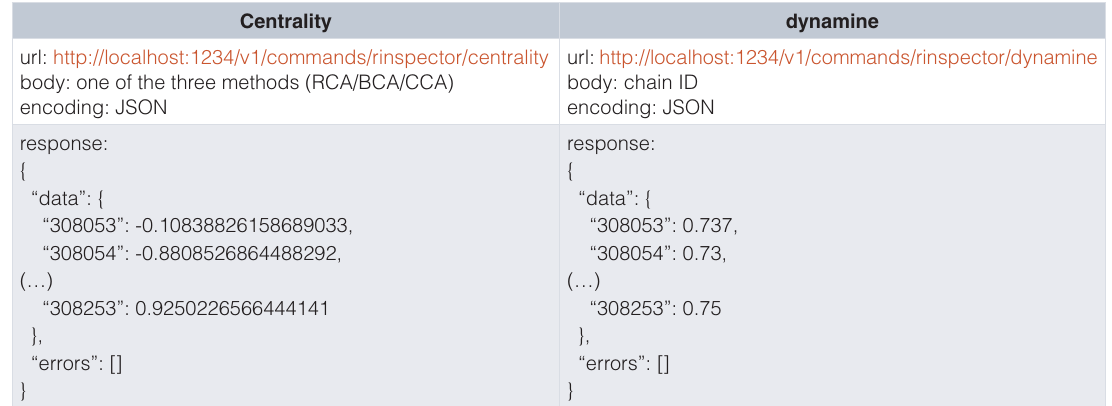
Table 1. Parameters and responses for centrality and dynamine POST requests. For each request to the REST service, the url, body and encoding format are specified. The response in both cases is a table that contains the Z-score (centrality) or the S² score (dynamine) associated to each node ID, in JSON